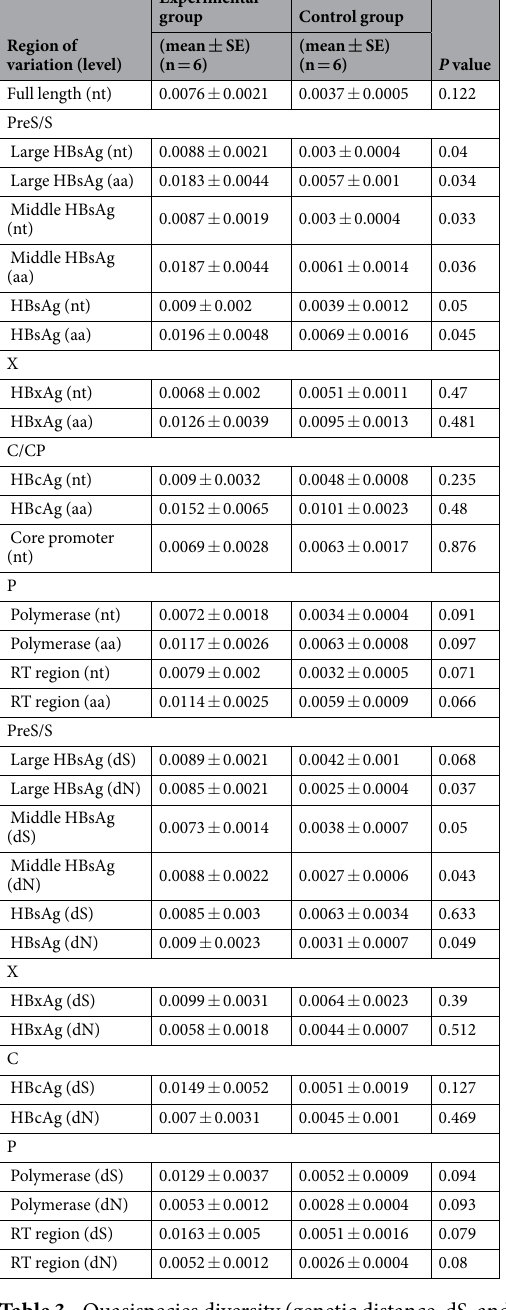
Table 3. Quasispecies diversity (genetic distance, dS, and dN) between the patients with coexisting HBsAg and anti-HBs and